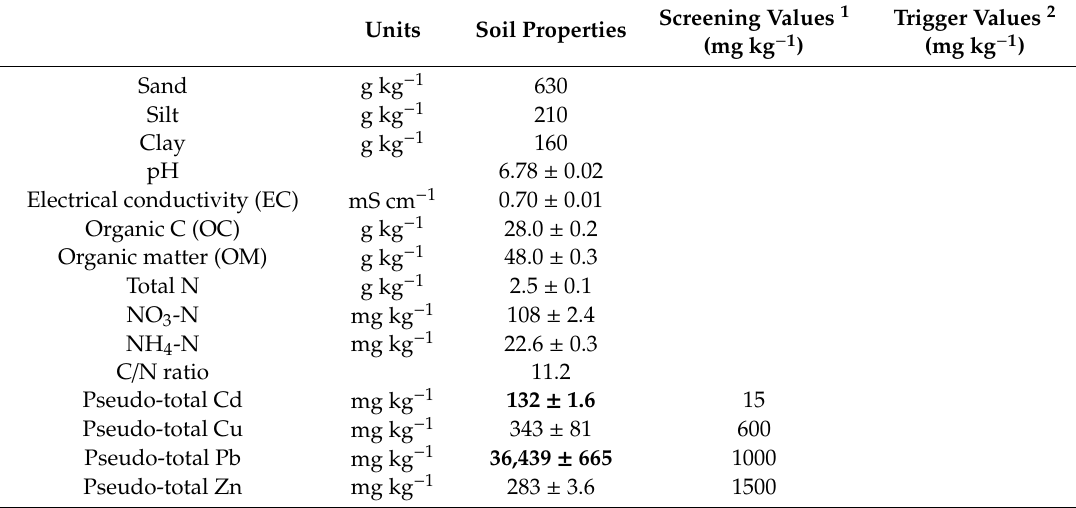
Figure 1. Map of the studied site and sampling point ( a ) in the industrial area of Marcianise (Campania, southern Italy) and growth chamber pot experiment with D. glomerata L. and a mixed stand of F. arundinacea Shreb. , L. perenne L. and P. pratensis L ( b ). Table 1. Physiochemical properties of the composite soil sample used in the pot experiment before plant sowing (number of replicates =